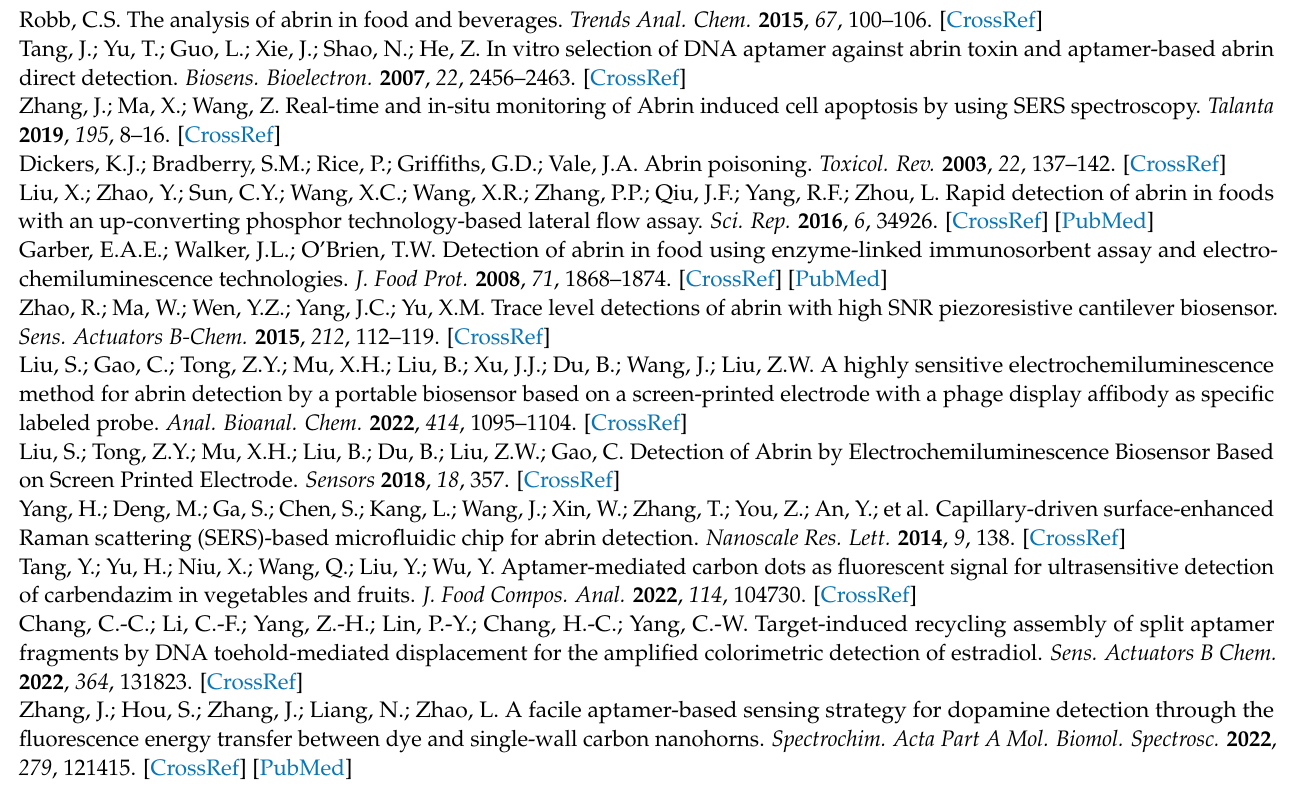
nucleotides, Table S3: Variables Entered/Removed, Table S4: Model Summary, Table S5: ANOVA, Table S6: Coefficients, Table S7: Interaction sites between abrin-M1 and